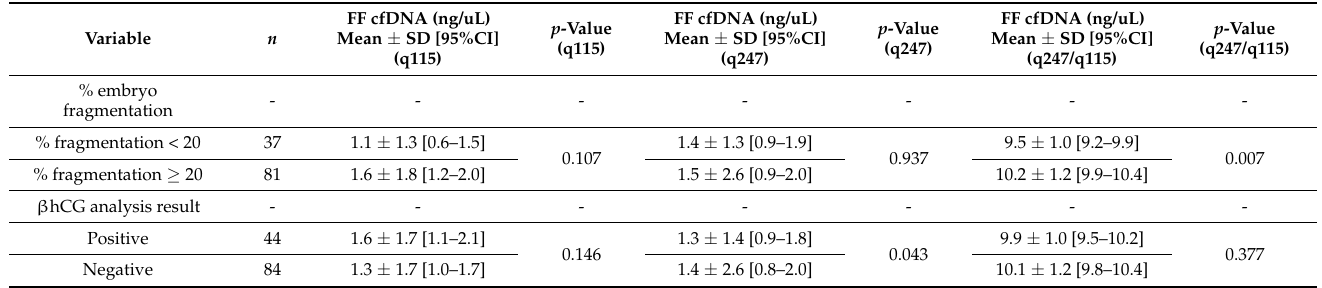
Table 5. Cell-free DNA levels according to embryo fragmentation and pregnancy